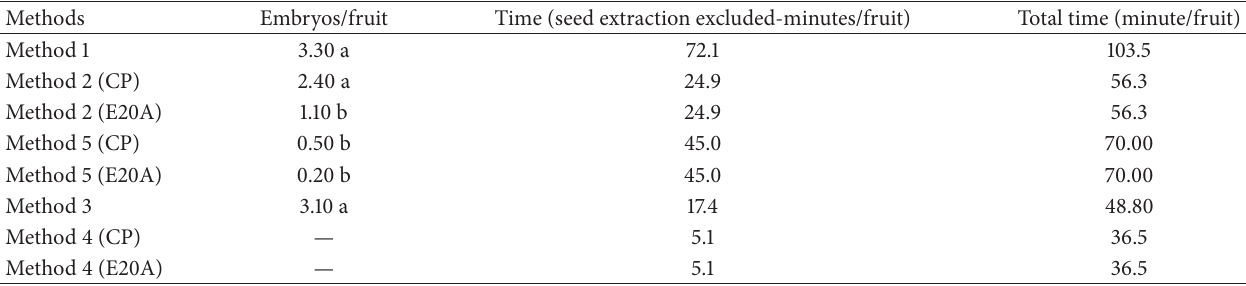
Table 3: Average embryo number per fruit obtained through different methods and time.